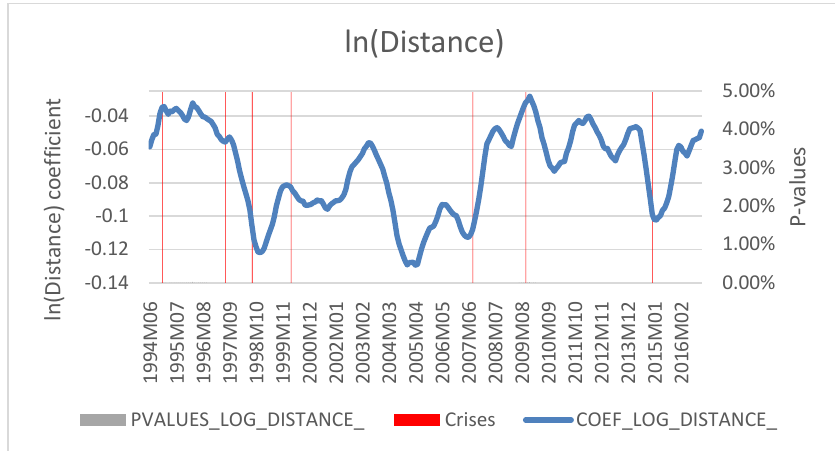
Figure 2. Coefficients and p -values for the ln (Distance) variable of the rolling regression. ( p -values are